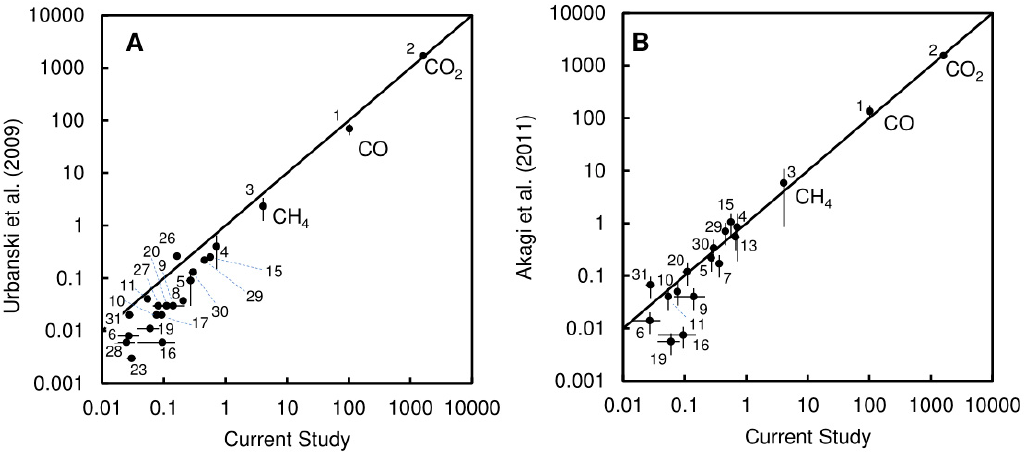
Figure 4. ( A ) Comparison of emission factors for CO, CO 2 , and VOCs obtained in the current study with those reported by [40]; and ( B ) comparison of emission factors for CO, CO 2 , and VOCs obtained in the current study with those reported by [41]. Points are labelled with numbers that correspond with the Species Number in Table 1.